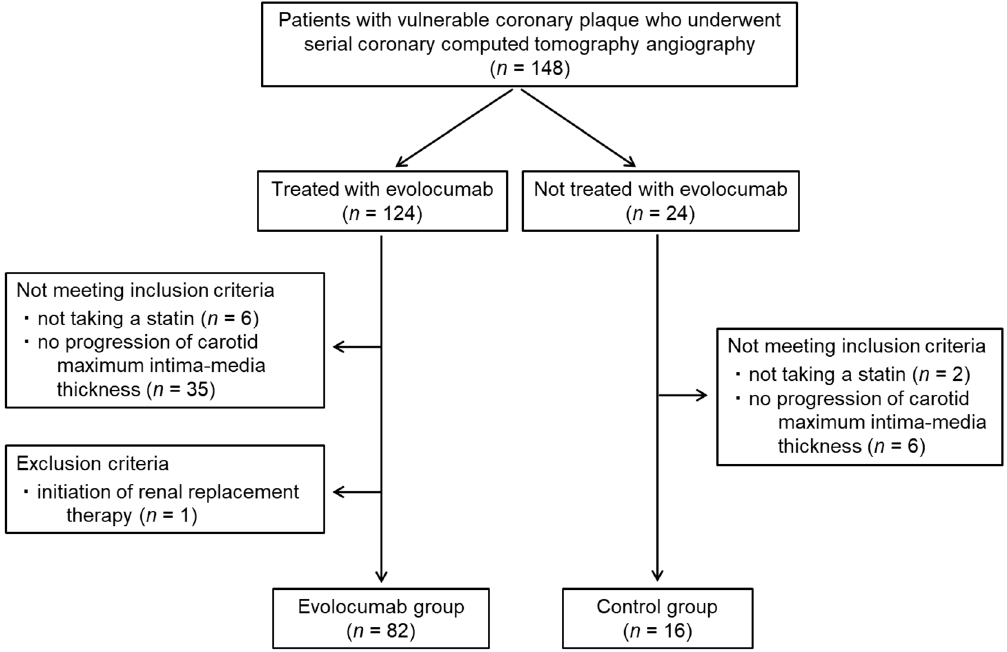
Figure 3. Patient flow diagram.